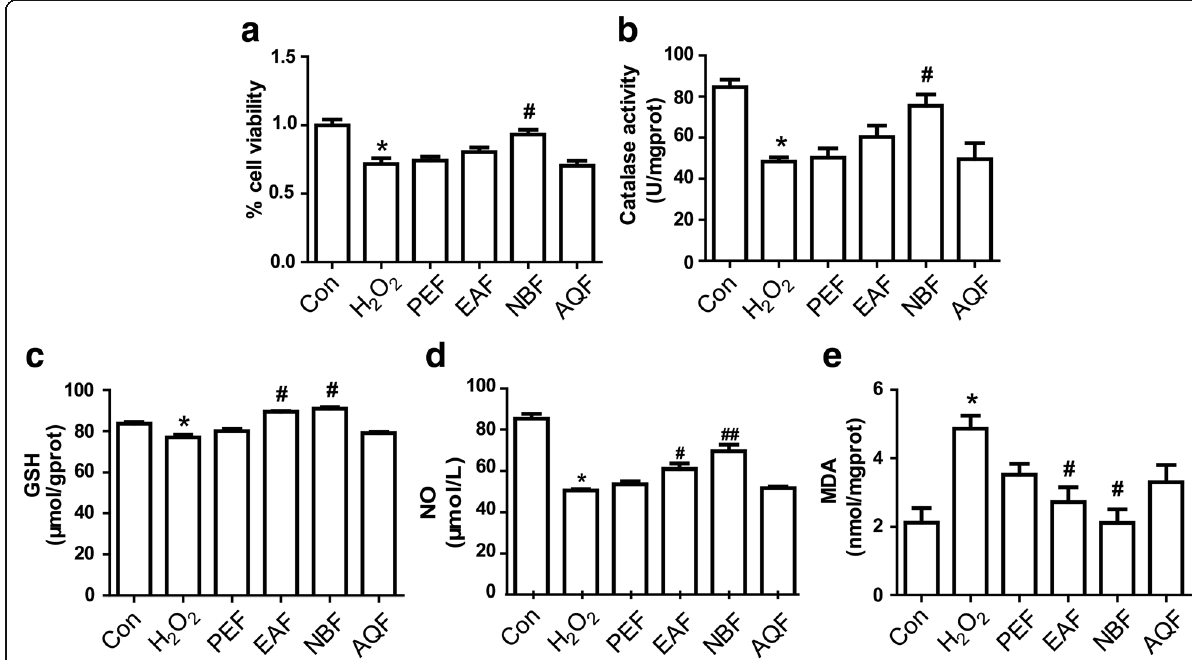
Fig. 1 Effects of the four extract fractions on cell viability ( a ), catalase activity ( b ), and levels of glutathione (GSH) ( c ), Nitric Oxide(NO) ( d ) and malondialdehyde (MDA) ( e ) in human umbilical vein endothelial cells subjected to H 2 O 2 -induced oxidative stress. *P < 0.05 vs. control. # P < 0.05 vs. H 2 O 2 alone. n = 12. Con: control; PEF: petroleum ether fraction; EAF: ethyl acetate fraction; NBF: n-butanol fraction; AQF: aqueous